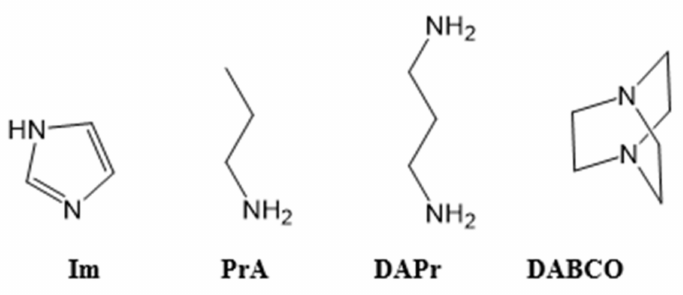
Figure 15. Structures of the ligands (Im, PrA, DAPr, DABCO).